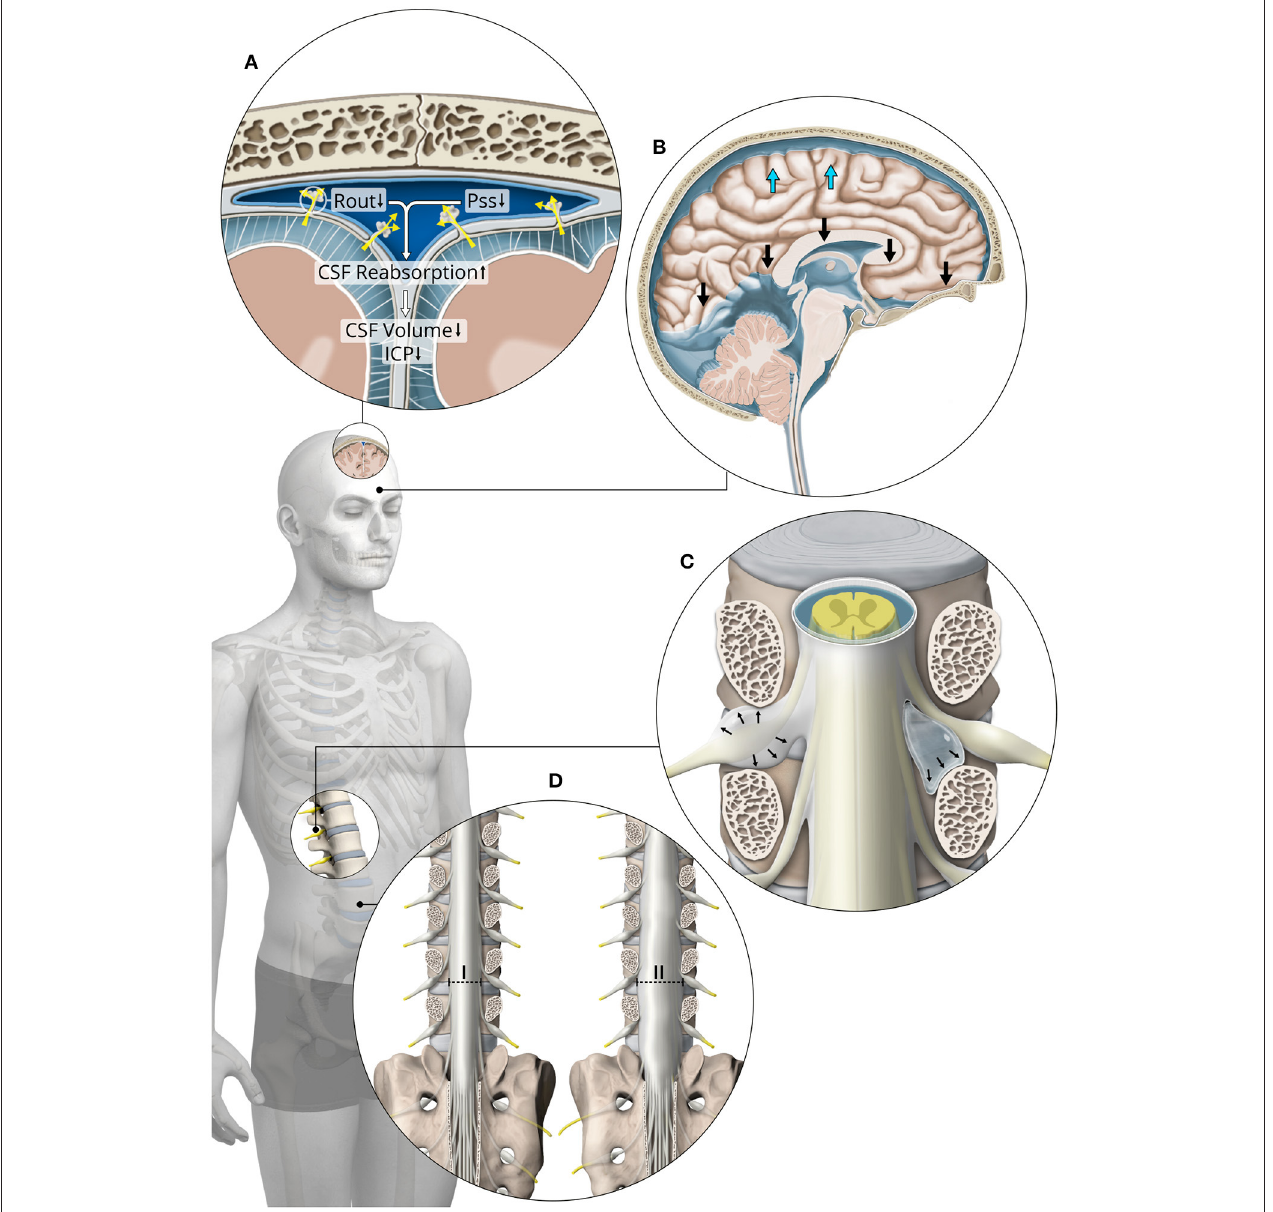
FIGURE 4 | Overview of factors contributing to internal SIH. Predisposing factors are (A) low CSF outflow resistance (Rout), low intracranial venous pressure (Pss) and (B) low intracranial CSF volume. The main pathophysiological factor is increased spinal compliance due to (C) meningeal diverticula, dural tears with prolapsing arachnoid around meningeal diverticula or (D) increased distensibility of the dura mater (I = normal distensibility, II = increased distensibility). A combination of these factors can lead to a pathological cranial-to-spinal CSF shift causing brain sagging (B) and orthostatic symptoms without CSF leakage.